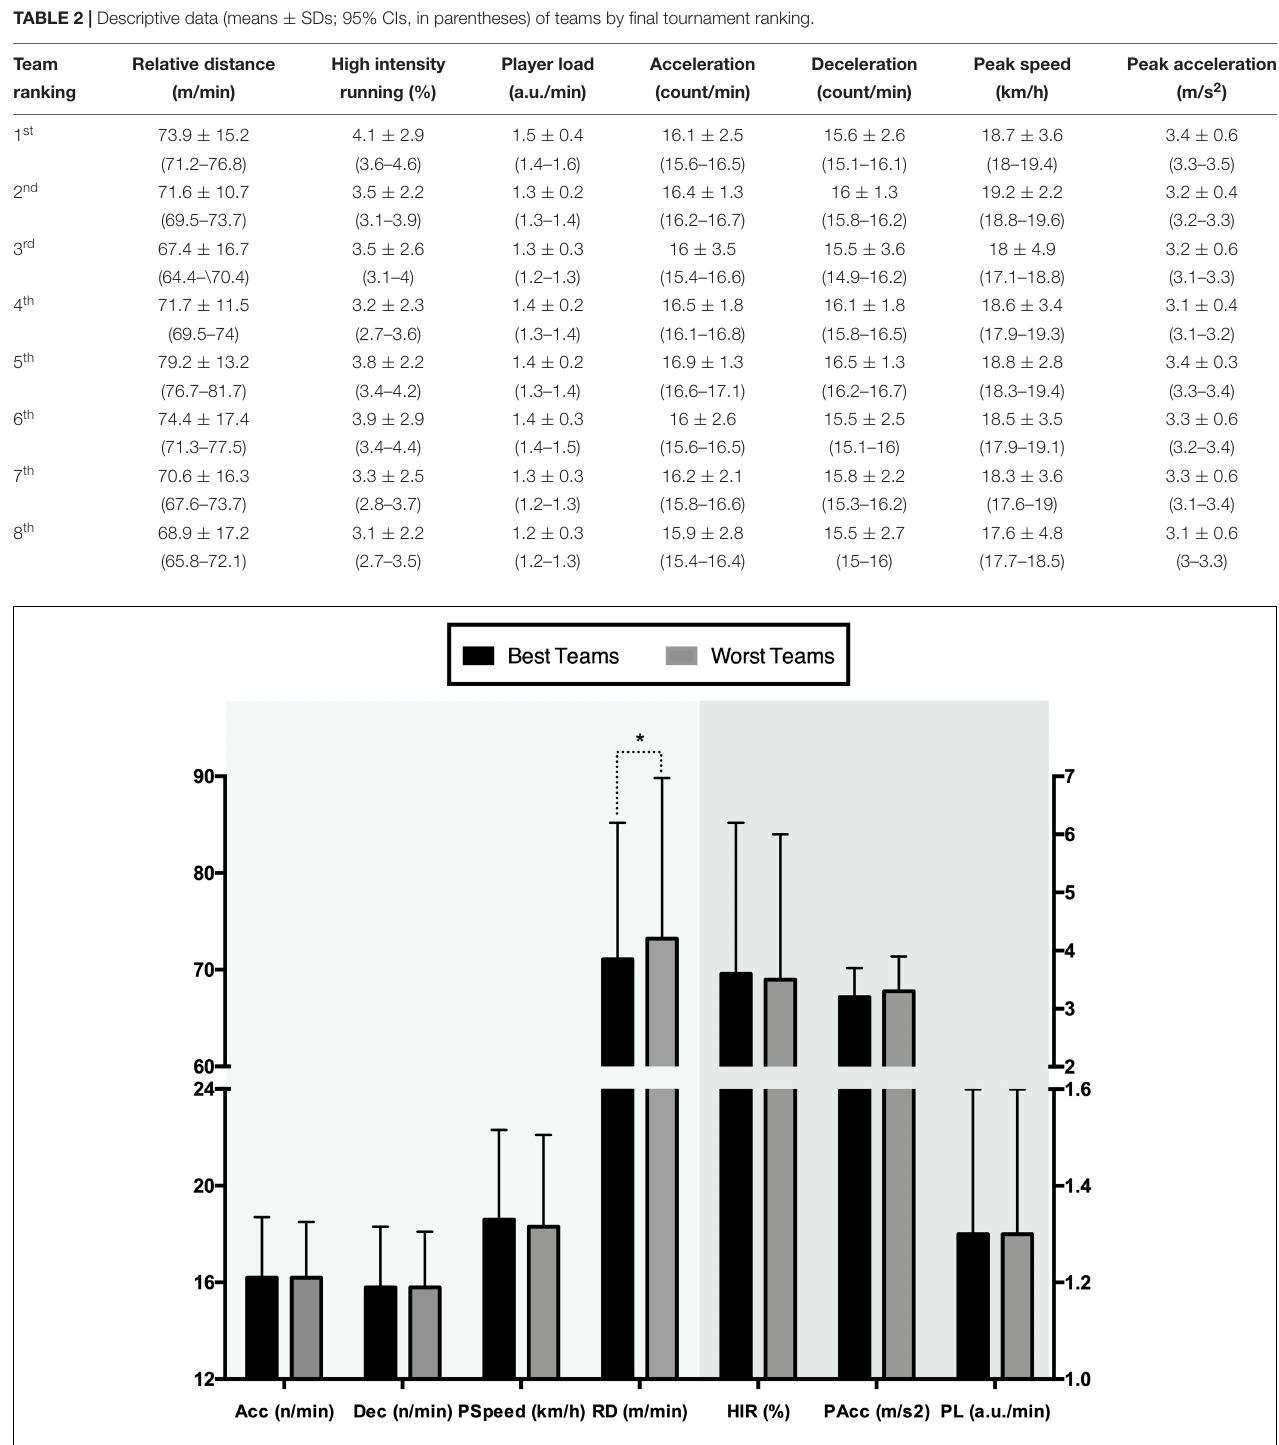
FIGURE 3 | Intensity variables by final tournament ranking (best four teams vs. worst four teams). ∗ p < 0.05.